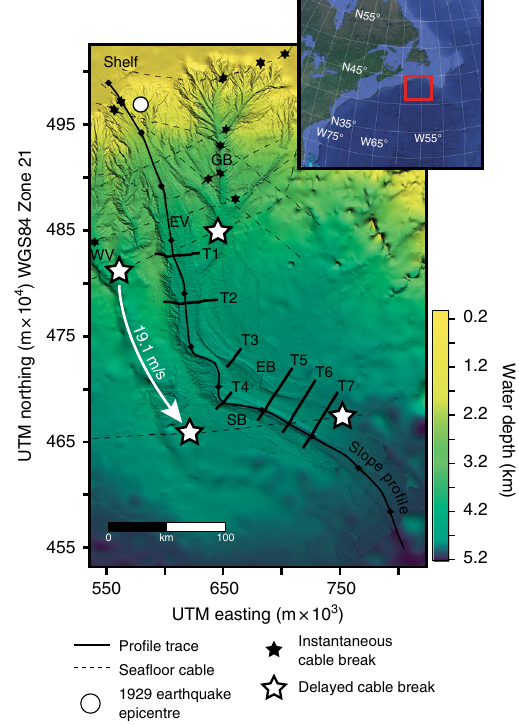
Fig. 1 Bathymetry of the Grand Banks slope shown via a General Bathymetric Chart of the Oceans (GEBCO) base map, which is overlain by higher-resolution swath bathymetry collected aboard Cruise MSM47 in 2015. Several major channel systems were pathways for the 1929 fl ow: Western Valley (WV), Grand Banks Valley (GB), and Eastern Valley (EV), which splits into two smaller channels: East Branch (EB) and South Branch (SB). Delayed cable breaks provide a direct measure of fl ow speed (19.1 ms − 1 ). A down slope pro fi le (Fig. 4) runs through the Eastern Valley channel system with 7 channel cross-section pro fi les (T1-T7) (Fig. 3). Insert map uses satellite imagery from Google Earth Pro